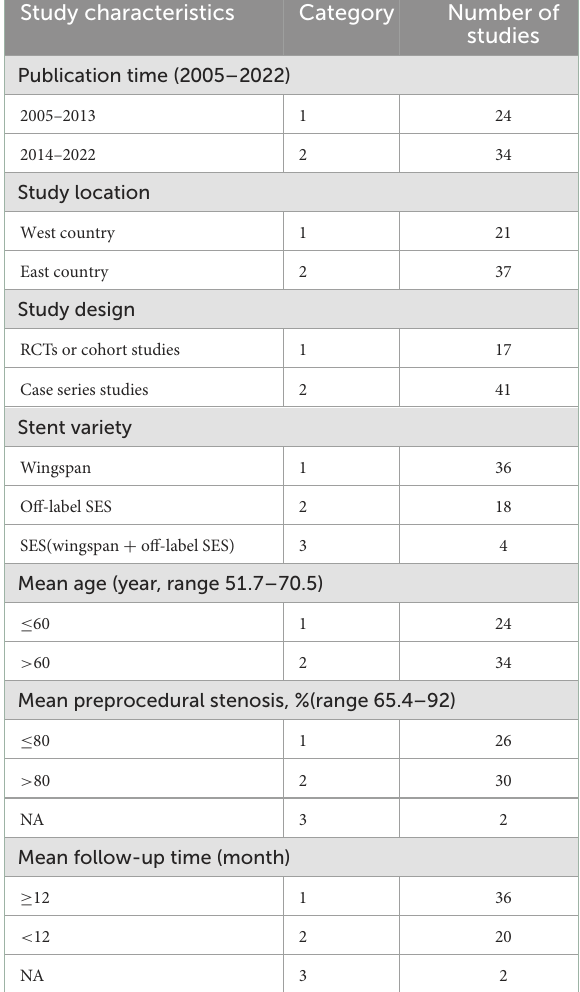
TABLE 1 Main characteristics of the 58 included studies. Supplementary Table 3. The pooled rate of each outcome was as follows (Table 2): perioperative TIA, 2.20% (95%